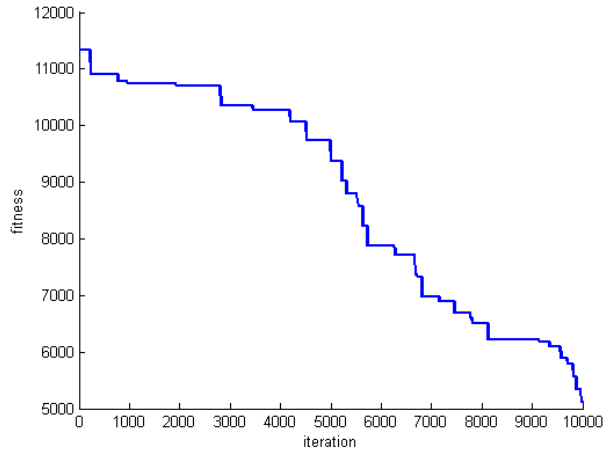
Figure 14. Changes of the best whale for a = 2 in DS 8 .